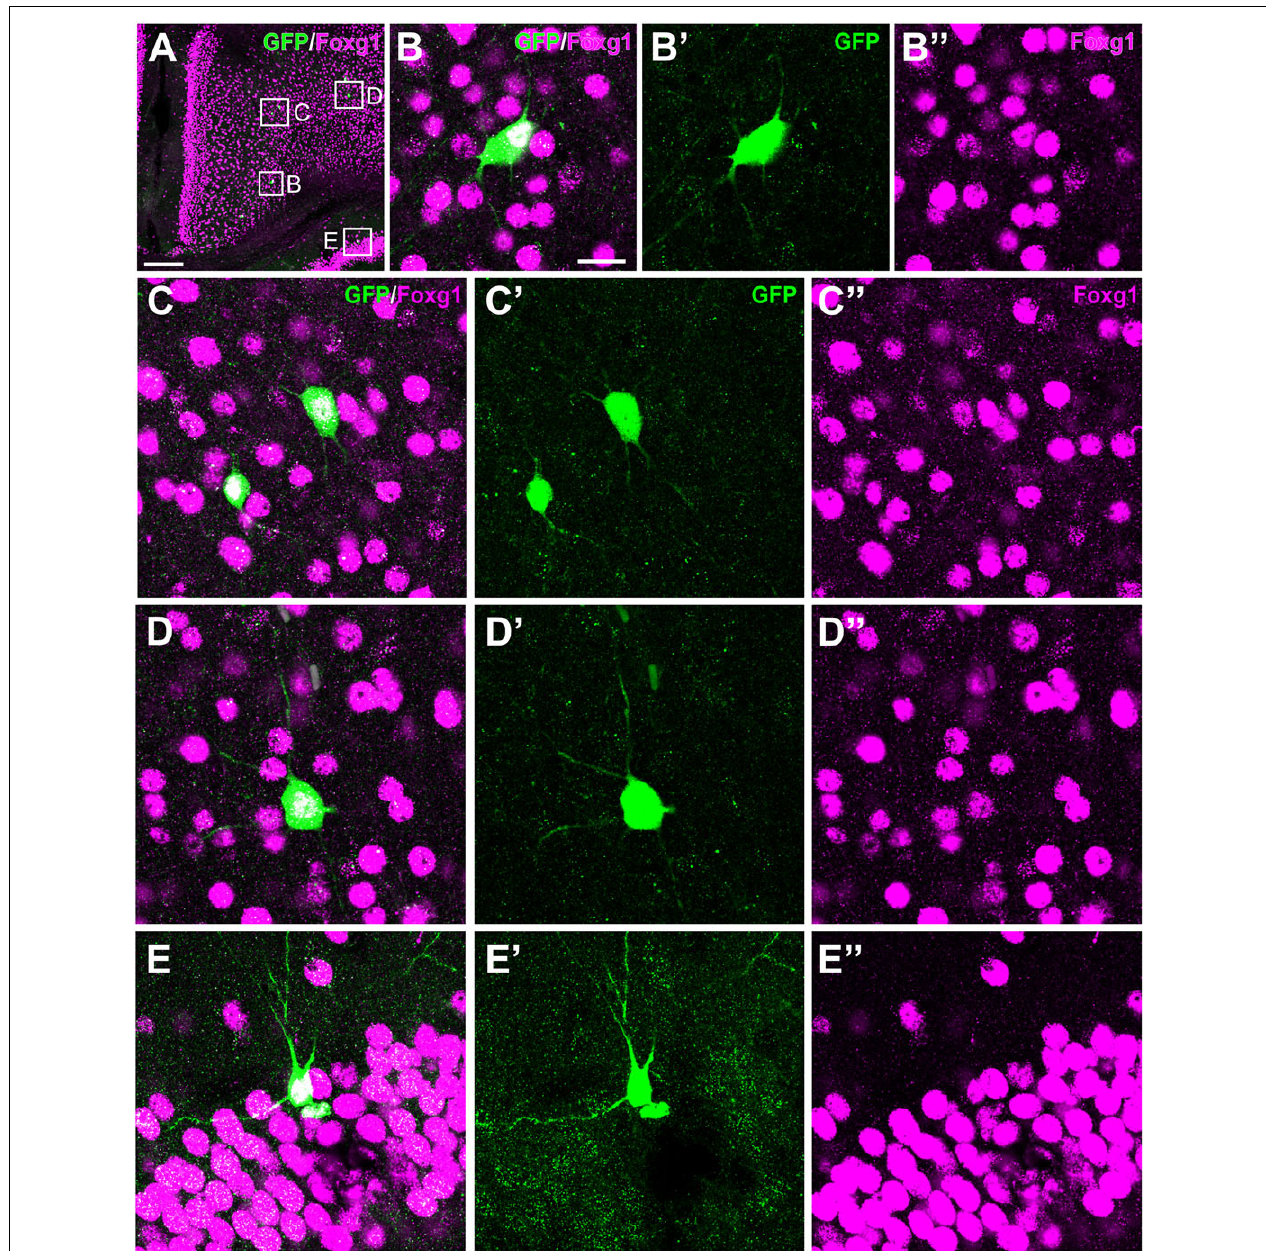
FIGURE 11 | Colocalization of GFP and Foxg1 in the mesocortex, neocortex and hippocampus. Images of frontal brain sections of P19 Otp-eGFP mice, processed for double immunofluorescence to detect GFP (green) and Foxg1 (magenta). Panel (A) shows the cingulate mesocortex and adjacent neocortex, and details of double labeled cells are shown in panels (B–B (cid:48)(cid:48) ,C–C (cid:48)(cid:48) ,D–D (cid:48)(cid:48) ) . Panels (E–E (cid:48)(cid:48) ) shows a double labeled cell in CA1. Scale bar: panel (A) = 200 µ m. Panel (B) = 20 µ m [it applies to panels (B–E (cid:48)(cid:48) )